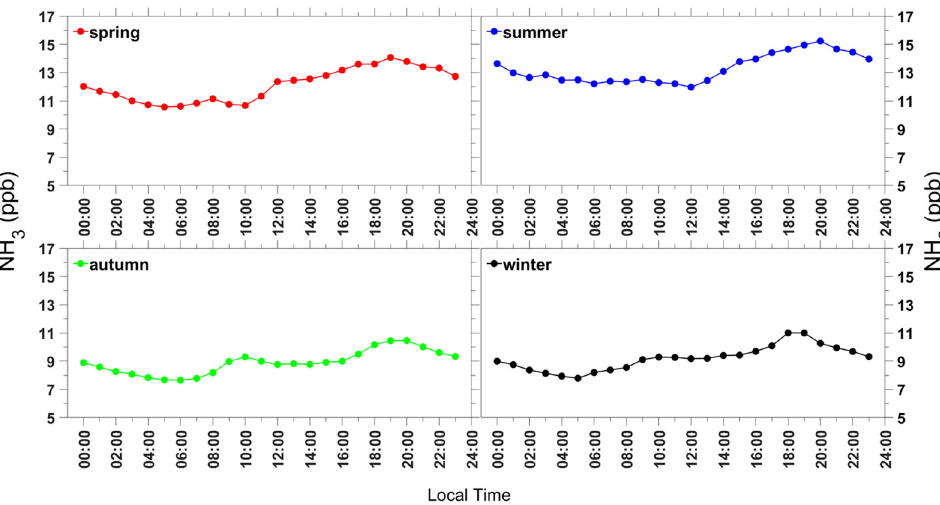
Figure 2. Seasonality of hourly averaged diurnal variations of atmospheric NH 3 at the monitoring